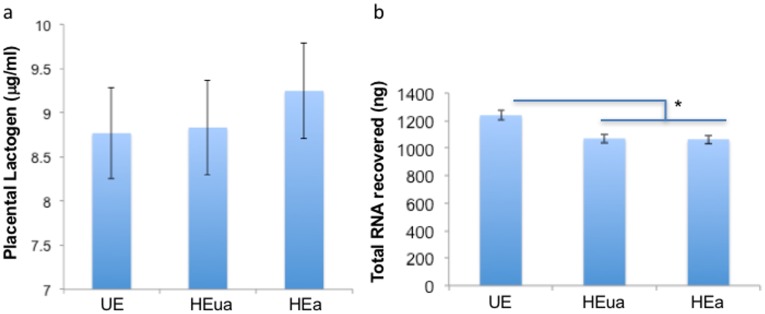
Placental Lactogen (hPL) and total RNA content in maternal plasma samples.(a) Plasma placental lactogen content in late pregnancy was not significantly different among HEa, HEua and UE groups. (b) Analysis of total plasma RNA content indicated that there was a statistically significant, ~15% decrease in total RNA recovery in the alcohol exposure groups (HEa and HEua) compared to UE controls.